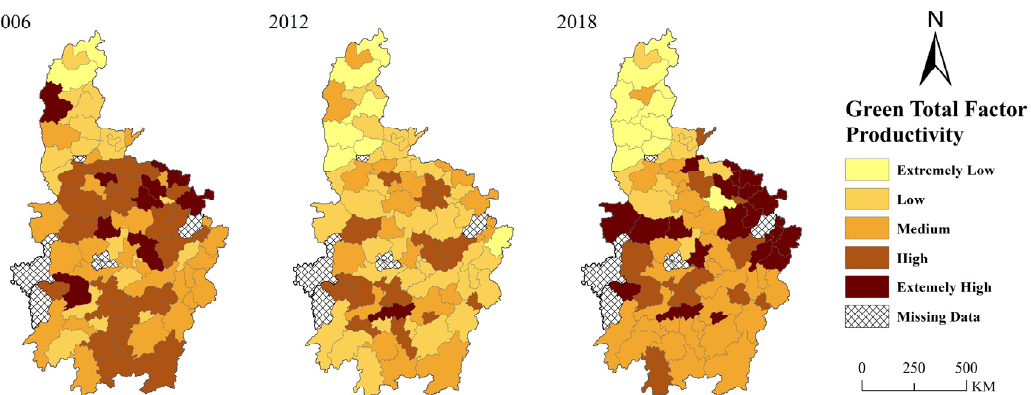
Figure 5. Variation of green total factor productivity in Central China. Note: Built by the authors based on the data calculated through the abovementioned method.